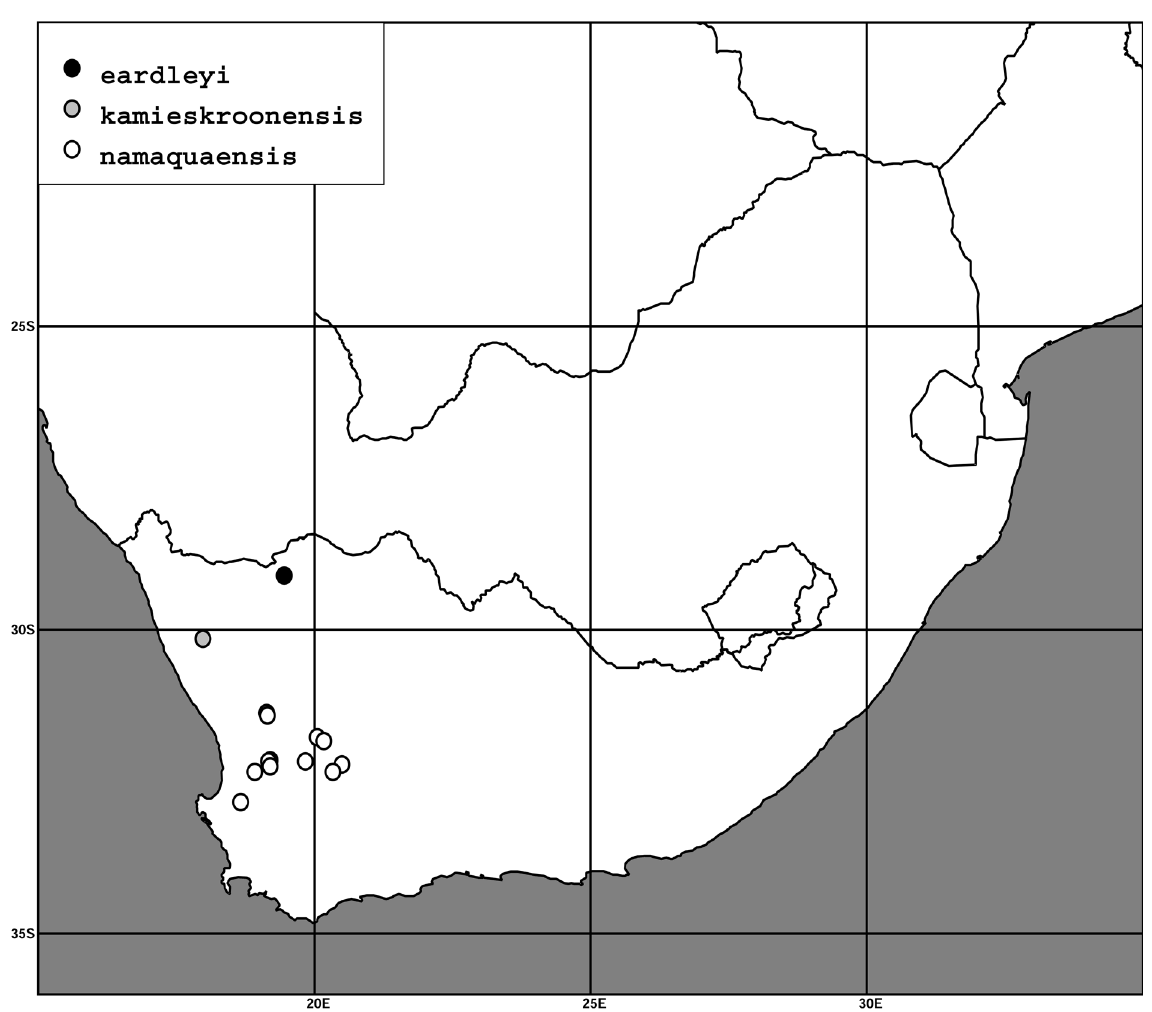
Fig. 9. Distribution of Redivivoides eardleyi sp. nov., R. kamieskroonensis sp. nov. and R. namaquaensis sp. nov. in South